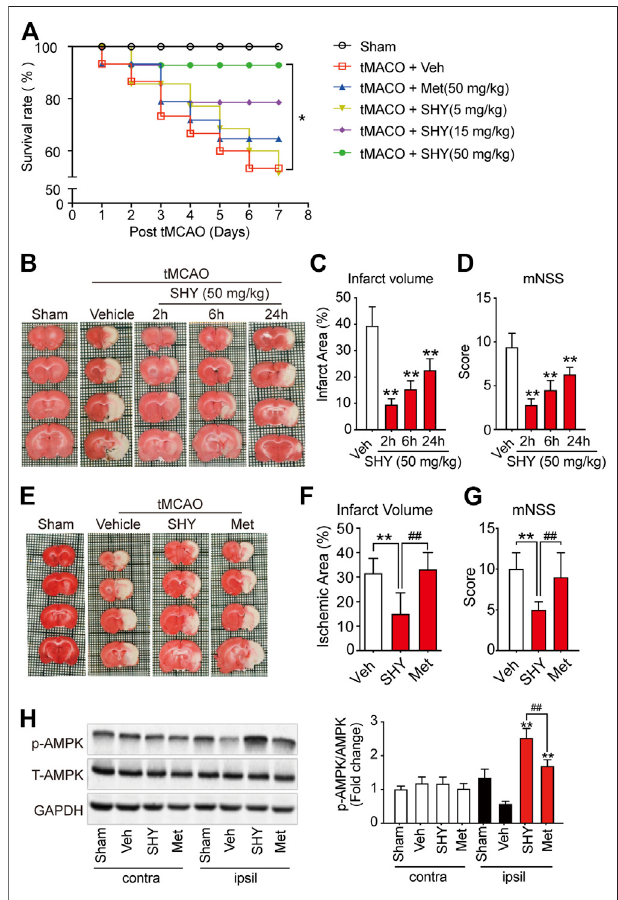
FIGURE4| SHY-01amelioratesinfarctareaintMCAO-inducedcerebral ischemic stroke. (A) SHY-01 (SHY, 5, 15, or 50 mg/kg) or metformin hydrochloride (Met, 50 mg/kg) were administrated ( i.p. ) every 24 h after